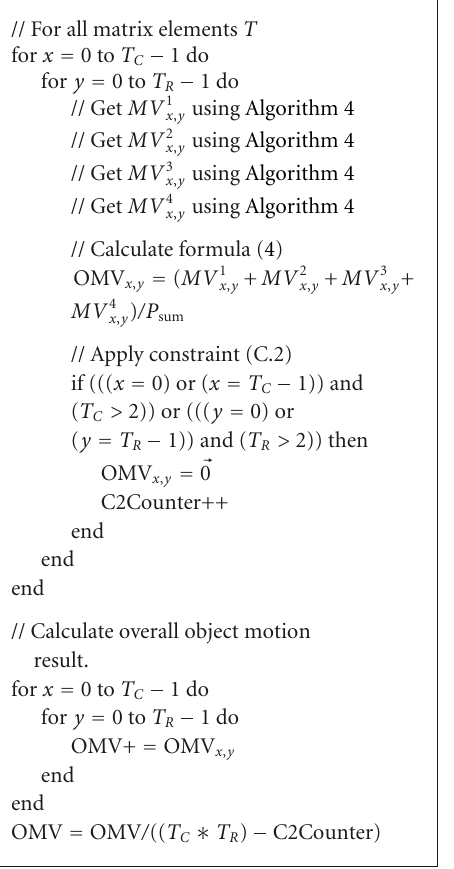
Algorithm 3: Calculate OMV.